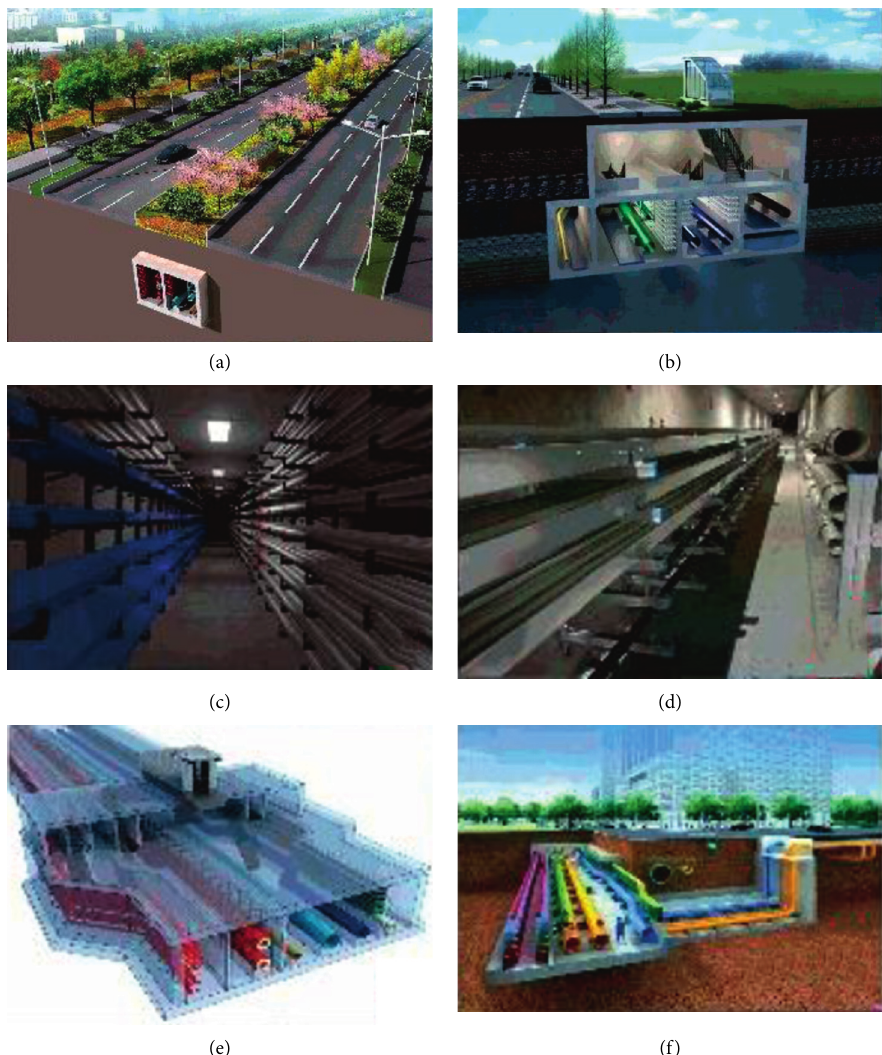
Figure 1: Utility tunnel. (a) Single-floor utility tunnel. (b) Double-floor utility tunnel. ((c) and (d)) Utility lines inside the utility tunnel. ((e) and (f)) The section of utility